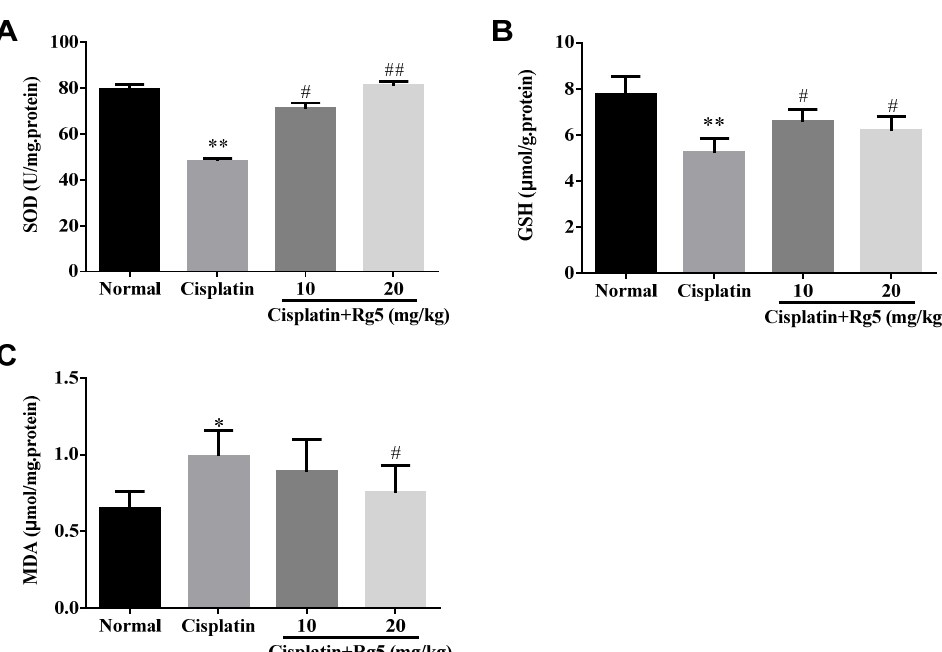
Figure 3. Effects of Rg5 on the levels of: SOD ( A ); GSH ( B ); and MDA ( C ) in cisplatin-induced nephrotoxicity. All data were expressed as mean ± S.D., n = 8. * p < 0.05, ** p < 0.01 vs. normal group; # p < 0.05, ## p < 0.01 vs. cisplatin group. GSH = glutathione; SOD = superoxide dismutase; MDA = malondialdehyde.